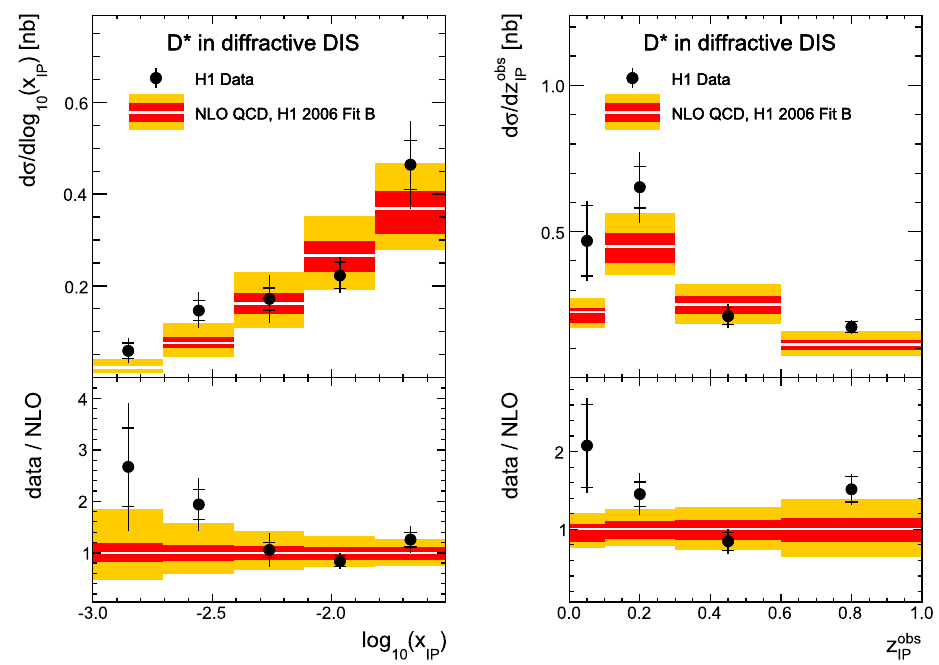
. Further details are indicated IP